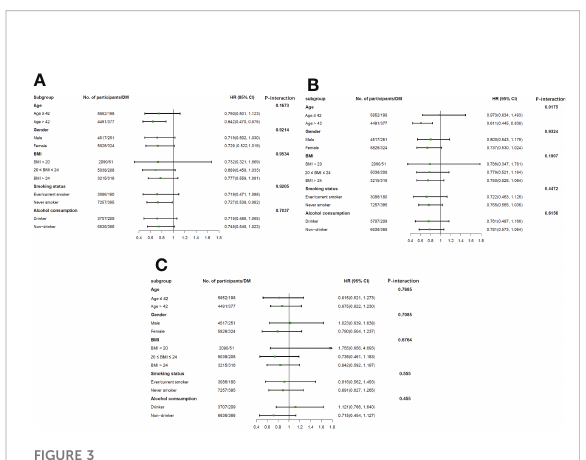
FIGURE 3 Association of total (A) , occupational (B) , and domestic physical activity (C) with diabetes incidence strati fi ed by age, sex, BMI, smoking status, and alcohol consumption. Notion: All models were adjusted for age and gender (male or female), marriage status (married or not), educational attainment levels (low, medium, or high), household income per capita levels (low, medium, or high), and urbanization index, smoking status (ever/ current or never smoker), alcohol consumption (yes or no), total energy intake, SBP, DBP and BMI. The results were the HR (95% CI) of diabetes incidence according to the quartiles of total PA, occupational PA, and domestic PA. HR, hazard ratio; DM, diabetes mellitus; PA, physical